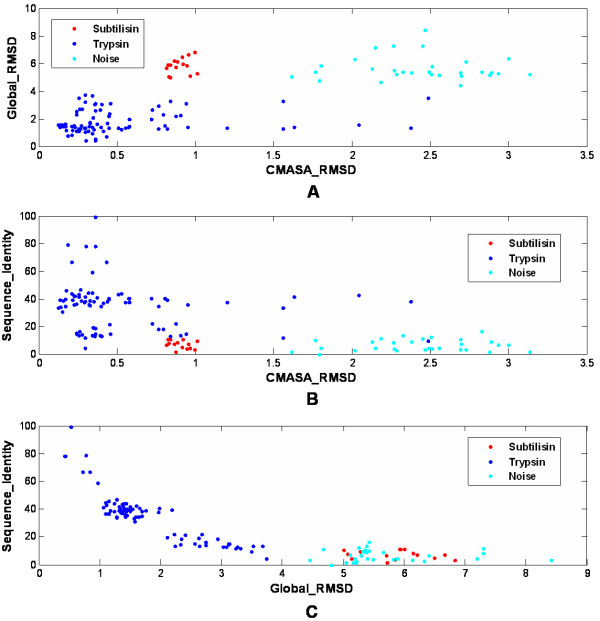
CMASA compare with sequence-based, global structure-based methods. A: The relationship between the CMASA RMSD and the global RMSD. B: The relationship between the CMASA RMSD and the sequence identity. C: The relationship between global RMSD and the sequence identity. 85 trypsins, 15 subtilisins and 30 random structures from the nrSCOP were selected for comparison. The CMASA_RMSD was calculated between 1mct active site (H57, D102 and S195) and the hits by the CMASA. The global_RMSD was calculated by CE package[8]. Sequence identity was calculated from structure-based sequence alignment.